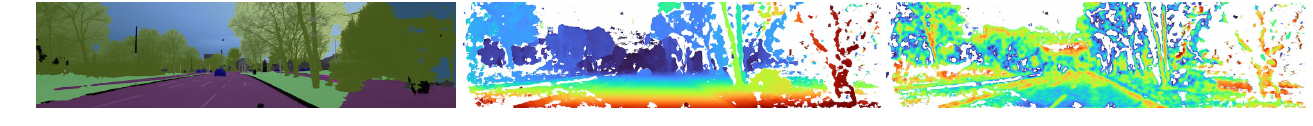
Figure 2. The three input images to our stereo vision-based grid mapping pipeline used in [23]. © 2021 IEEE. Reprinted, with permission, from Richter, S.; Beck, J.; Wirges, S.; Stiller, C. Semantic Evidential Grid Mapping based on Stereo